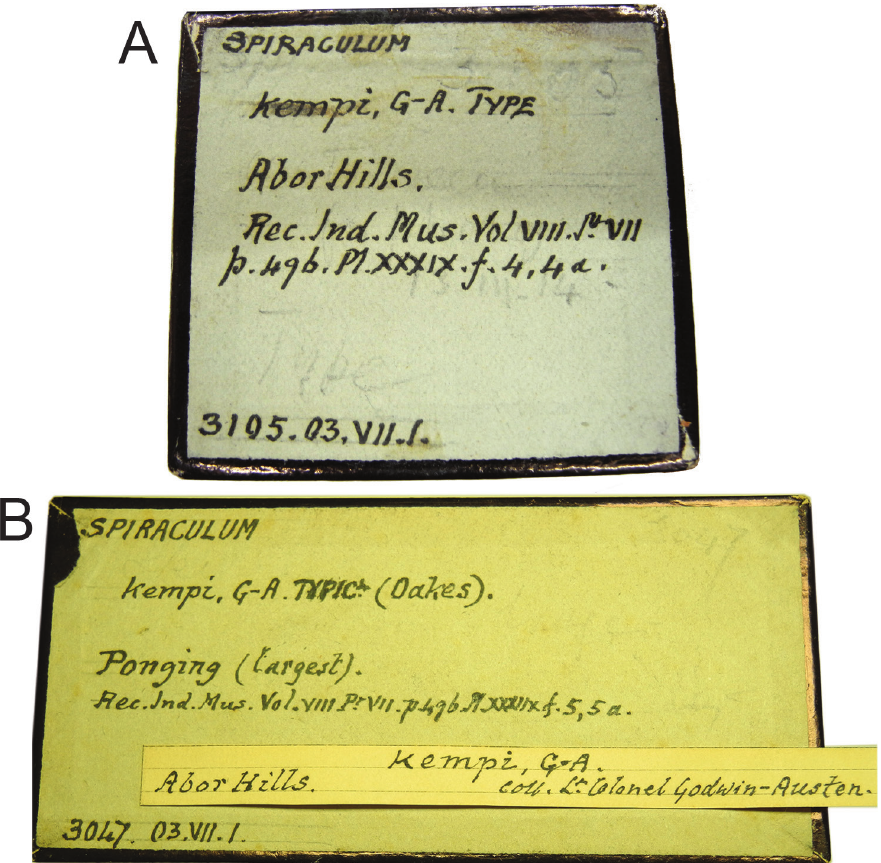
Figure 4. Original labels bearing Godwin-Austen’s handwriting of Spiraculum kempi A NHMUK 1903.7.1.3105 with the word “Type” and B NHMUK 1903.7.1.3047 with the word